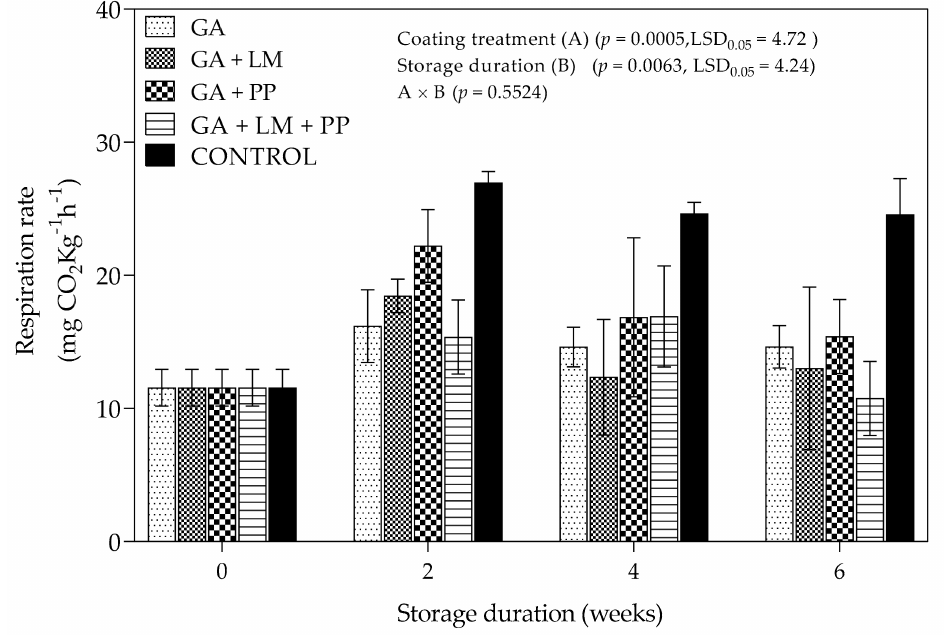
Figure 4. Respiration rate (mg CO 2 Kg − 1 h − 1 ) of ‘Wonderful’ pomegranate fruit coated with gum arabic (GA) coatings enriched with lemongrass oil (LM) (0.1% v/v ) and/or pomegranate peel extract (PP) (1% w/v ) and stored at 5 ± 1 ◦ C (95 ± 2% RH) for 6 weeks followed by 5 d at shelf-life conditions (20 ± 1 ◦ C and 60% RH). Vertical bars represent the standard error (SE) of mean value of three replicates (3 fruit per replicate). LSD 0.05 represents least significant difference ( p <